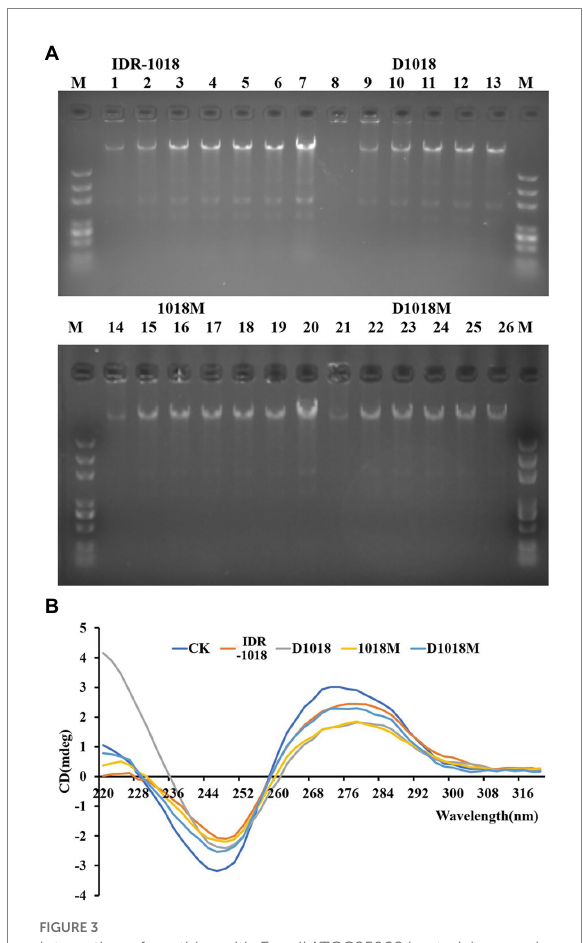
FIGURE 3 Interaction of peptides with E. coli ATCC25922 bacterial genomic DNA. (A) Interaction of IDR-1018, D1018, 1018M, and D1018M with bacterial genomic DNA by a gel migration assay. M: DNA marker; 1–6: The concentration of IDR-1018 were 0, 0.625, 1.25, 2.5, 5, and 10 μ g/mL, respectively. 8–13: The concentration of D1018 were 0, 0.625, 1.25, 2.5, 5, and 10 μ g/mL, respectively. 14–19: The concentration of 1018M were 0, 0.625, 1.25, 2.5, 5, and 10 μ g/mL, respectively. 21–26: The concentration of D1018M were 0, 0.625, 1.25, 2.5, 5, and 10 μ g/mL, respectively. 7 and 21: Genomic DNA from E. coli ATCC25922 with no peptide. (B) CD spectra of genomic DNA from E. coli ATCC25922 in the presence of IDR-1018, 1018M, D1018, and D1018M. The concentration of peptide and DNA were 40 and 150 μ g/mL,